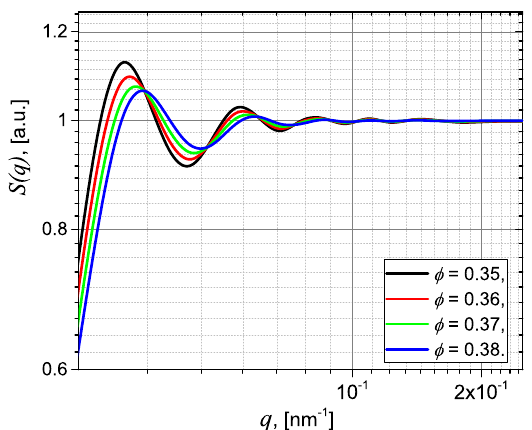
Figure 5. (Color online) Structure factor given by Equation (14) at different values of particle volume fractions φ .